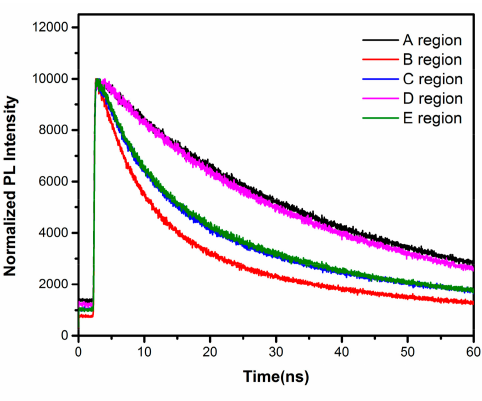
Figure 7. TRPL lifetime in regions A, B, C, D and E of large-area perovskite MAPbI 3 thin